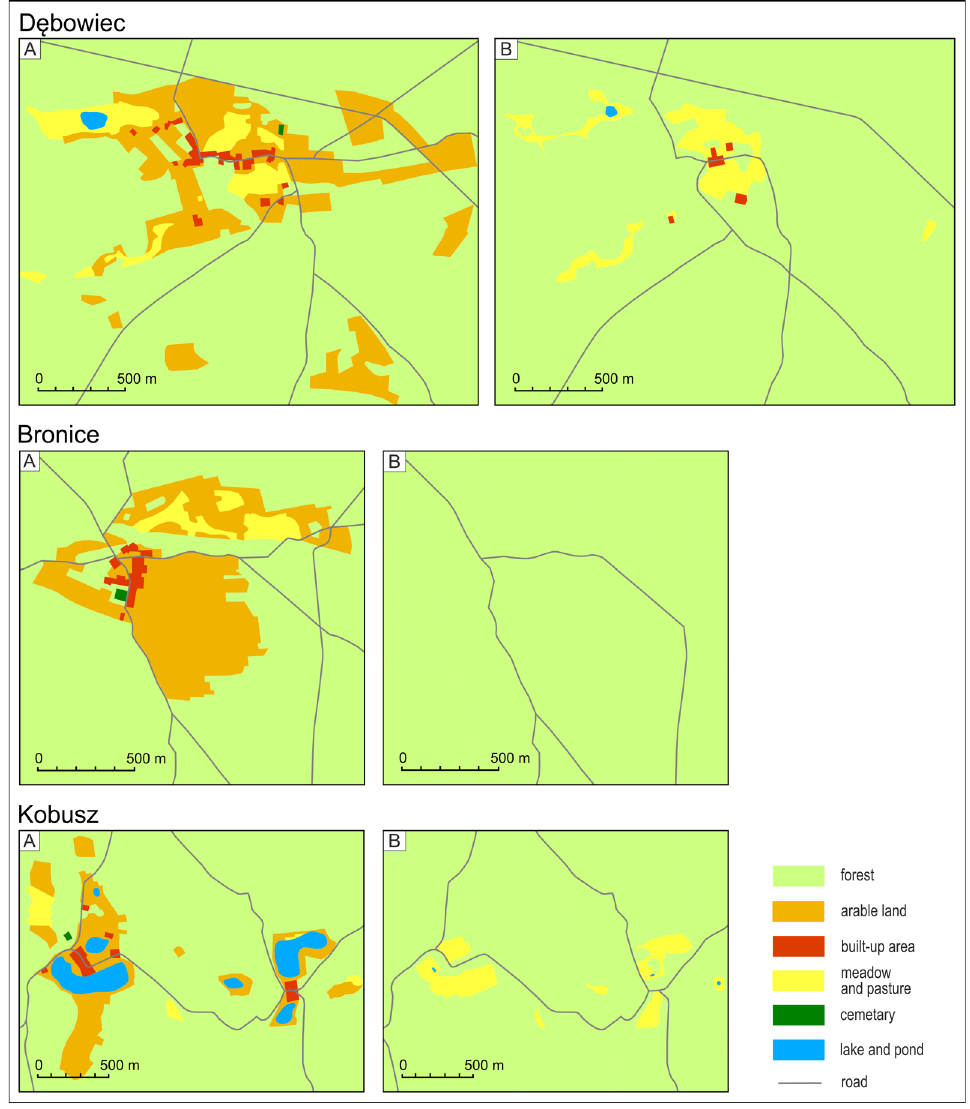
Fig. 5. Changes in land use structure in the villages of Dębowiec, Bronice and Kobusz: A –